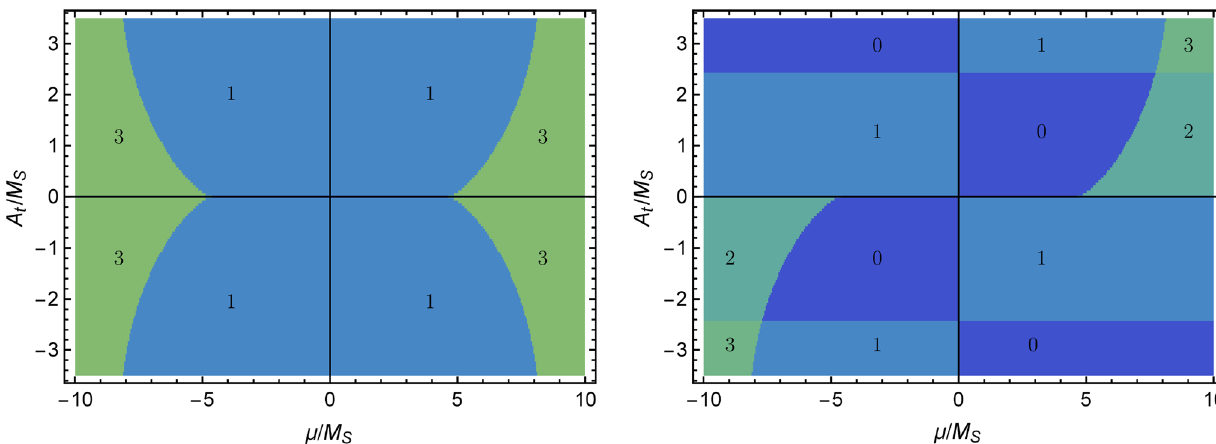
Fig. 1 Number of real solutions to the one-loop alignment condition, Eq. (17). We set Z 1 v 2 = 125 GeV. Left: All solutions with real tan β ; right: Real, positive tan β